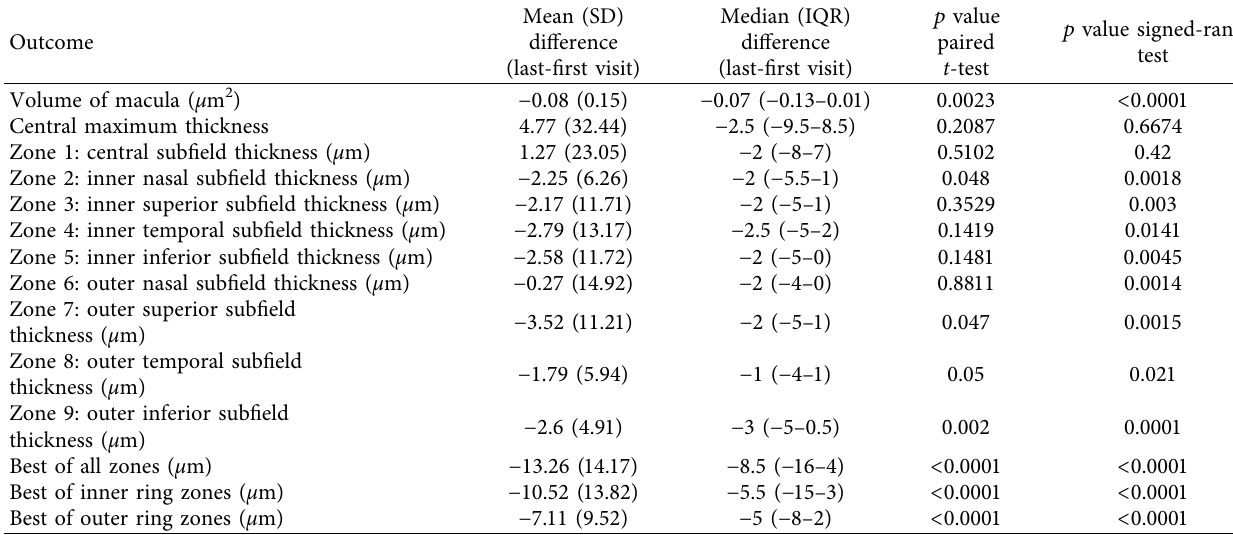
Table 3: The mean and median OCTmeasurements for the maculae of the 24 patients who completed the study. The table includes values for each of the 9 macular zones and a best improvement for all zones determination. Parametric (paired t -test) and nonparametric (signed-rank test) stats testing have been applied.